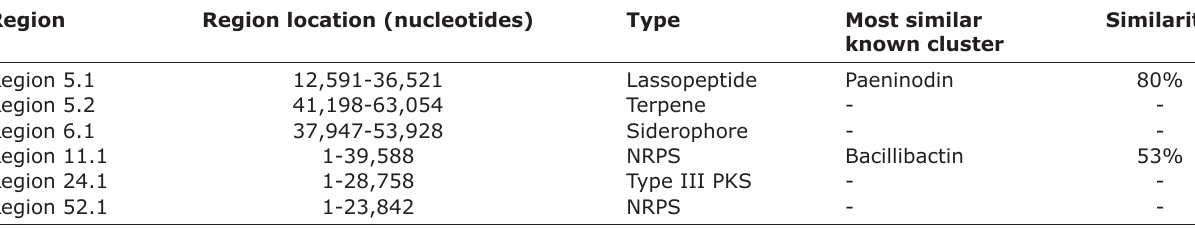
Table-4: Bacillus flexus / Priestia flexa (NZ_FMBD01000005.1). Region